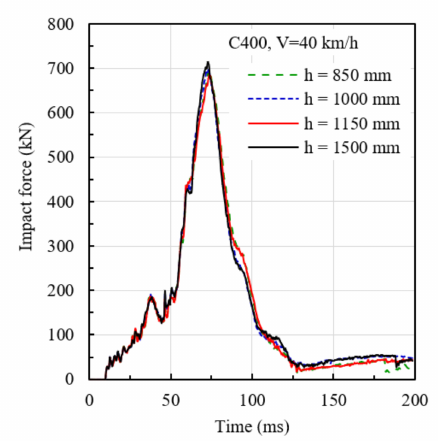
Figure 13. Effect of crushing height on the impact force.